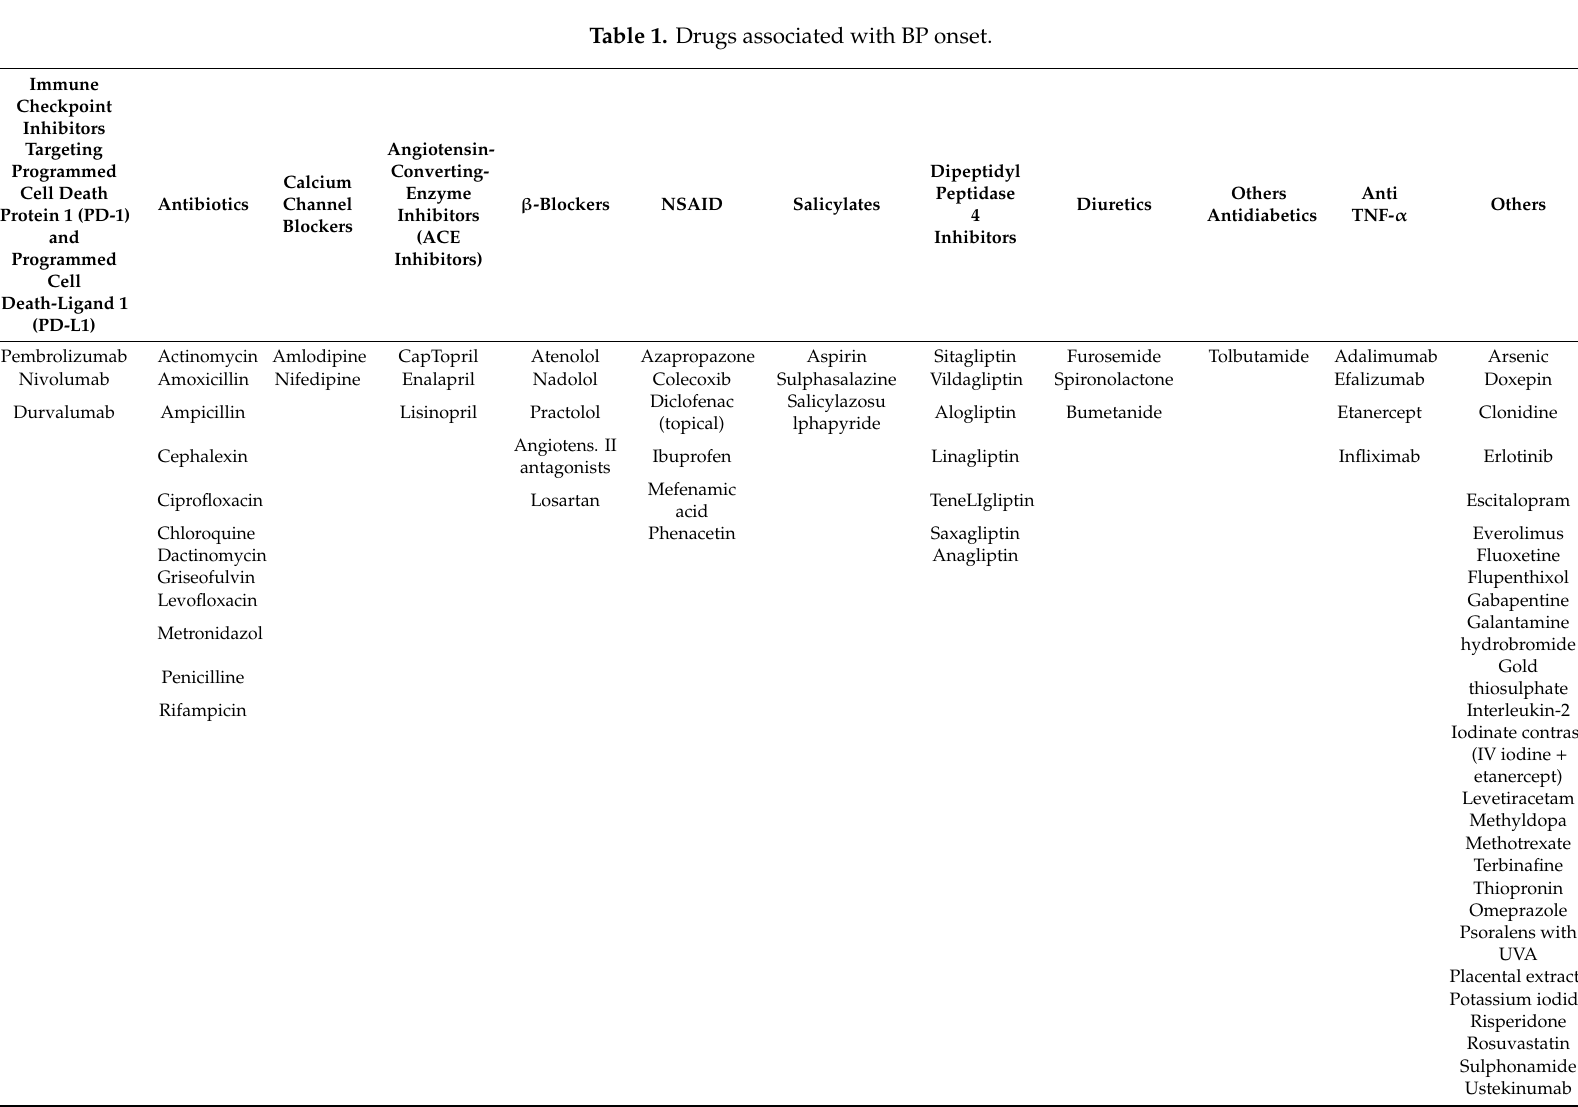
Table 1. Drugs associated with BP